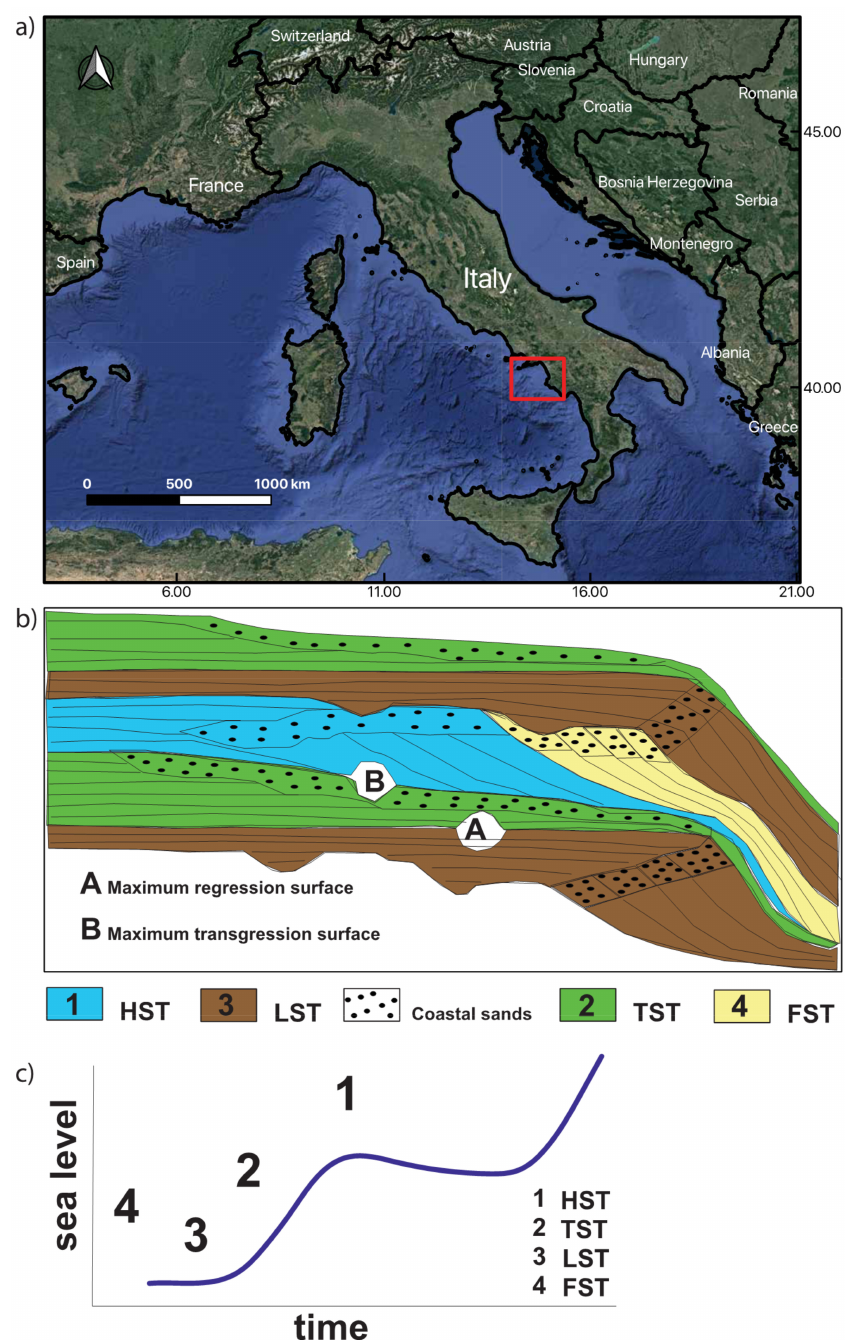
Figure 1. ( a ) Location map of the study area (red inset). ( b ) Sketch stratigraphic diagram as a function of depth ( c ) and time, showing the geometric relationships between the system tracts and the distribution of siliciclastic facies in unconformity-bounded depositional sequences.HST: Highstand system tract. TST: Transgressive system tract. LST: Lowstand system tract. FST: Forced regression system